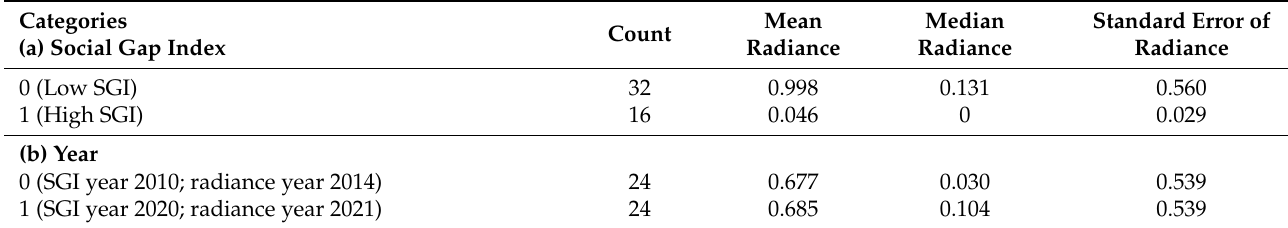
Table 5. Descriptive statistics of radiance in relation to SGI categories.